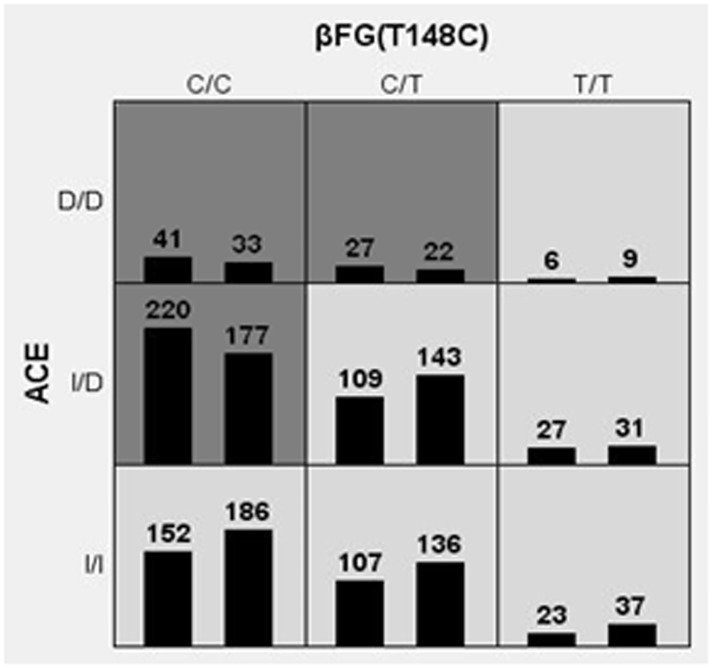
Distribution of ACE I/D and β-FG T148C genotype combinations.ACE I/D and β-FG T148C genotype combinations associated with high risk and with low risk for IS, along with the corresponding distribution of cases (left bars in cells) and of controls (right bar in cells). Dark-shaded cells indicate a high risk of IS (ACE DD + β-FG 148CC, ACE DD + β-FG 148CT, ACE ID + β-FG 148CC combinations); light-shaded cells indicate a low risk of IS (ACE DD + β-FG 148TT, ACE ID + β-FG 148CT, ACE ID + β-FG 148TT, ACE II + β-FG 148CC, ACE II + β-FG 148CT, ACE II + β-FG 148TT combinations).